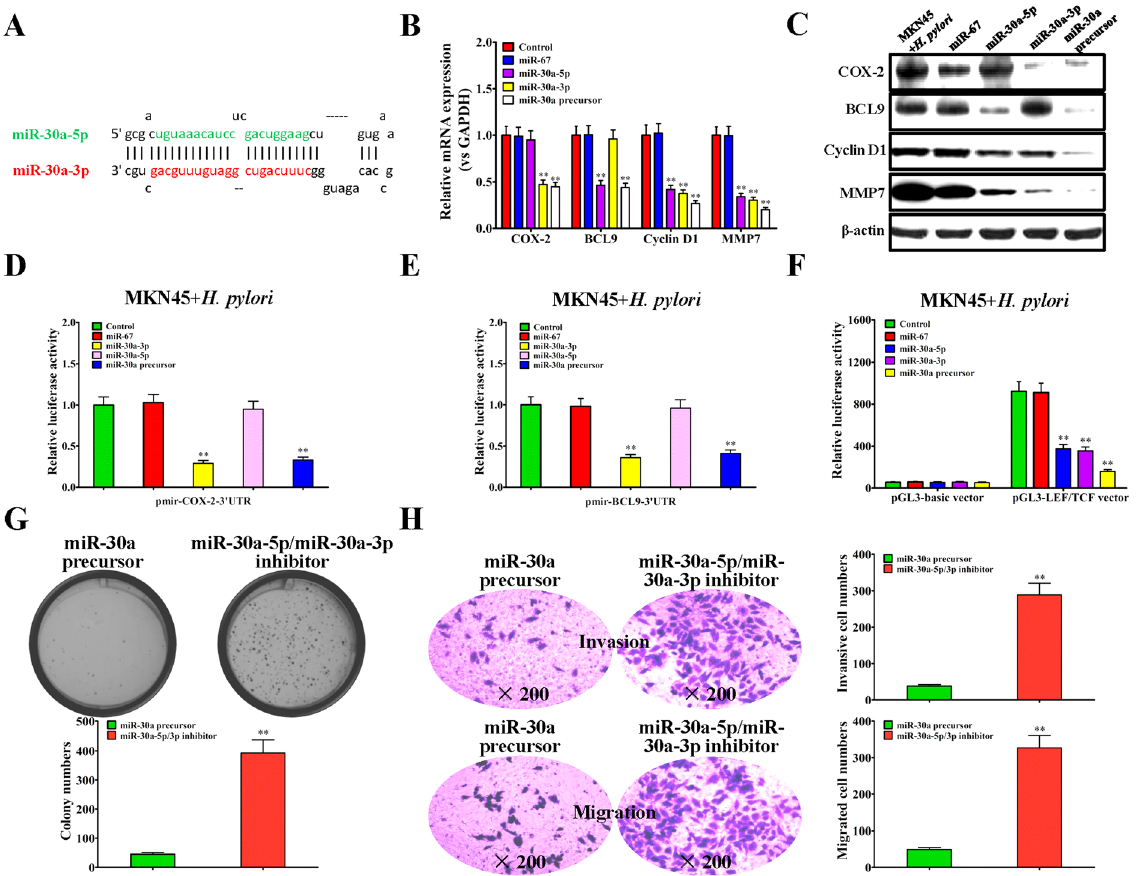
Figure 5. miR-30a precursor targets COX-2 and BCL9 to regulate the growth and migration of H. pylori infected gastric cancer cells. ( A ) Complementary stem-loop structure of the miR-30a precursor. ( B ) qRT- PCR assay for the effect of the miR-30a precursor on the transcriptional activity of COX-2, BCL9, Cyclin D1 and MMP7 in H. pylori -infected MKN45 cells, normalized to control H. pylori -infected MKN45 cells. ( C ) Western blot assay for the effect of miR-30a precursor on the protein expression of COX-2, BCL9, CyclinD1 and MMP7 in H. pylori -infected MKN45 cells. ( D ) Luciferase reporter activity assay for the effect of miR-30a precursor on the wild-type COX-2 3 ′ UTR reporter, normalized to control H. pylori -infected MKN45 cells. ( E ) Luciferase reporter activity assay for the effect of the miR-30a precursor on the wild-type BCL9 3 ′ UTR reporter, normalized to control H. pylori -infected MKN45 cells. ( F ) Luciferase reporter activities assay for the effect of miR-30a precursor on the LEF/TCF promoter in H. pylori -infected MKN45 cells, normalized to control H. pylori -infected MKN45 cells. ( G ) Colony formation assay of H. pylori -infected MKN45 cells transfected with the miR-30a precursor and miR-30a-5p/miR-30a-3p inhibitor (up), and the quantitative results of the colony formation numbers (down). ( H ) Invasion and migration assays of H. pylori -infected MKN45 cells transfected with the miR-30a precursor and miR-30a-5p/miR-30a-3p inhibitor (up), and the numbers of invasive and migrated cells were shown as mean ± SD, n = 3 (down). ** p < 0.01 by Student’s t test. All the results were reproducible in three independent